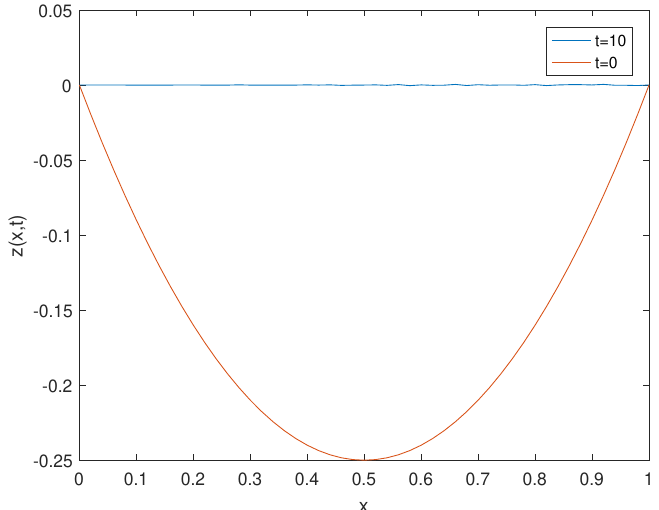
Figure 2. The state of system (19) for z ( x ,0 ) = x ( x − 1 ) , t = 0, and t = 10, illustrating the fact that (19) is unstable at t = 0 but it is stabilized at t = 10 on Ω =] 0,1 [